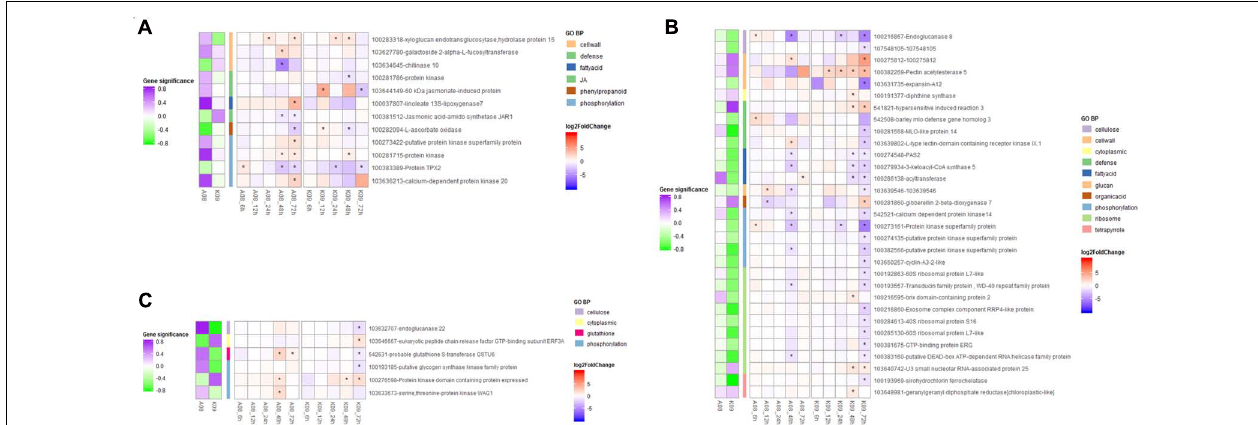
FIGURE 6 | Heatmaps of expression levels of 49 genes enriched in top 5 biological process GO terms identified through K-means clustering. (A) Heatmap of genes with significance discriminative in A08 from K09 at different stages. (B) Heatmap of genes with significance discriminative in K09 from A08 at different stages. (C) Heatmap of genes with significance showing opposite pattern between K09 from A08 at different stages. The different colors in the heatmap represent log2 fold change of each gene at different time points labeled on the bottom of the map, and stars indicate the statistical significance at p < 0.05. The colored side squares on the left of heatmap represent the overall significance level of each gene corresponding to that in the heatmap. The side bars with different color represent different GO terms shown on the